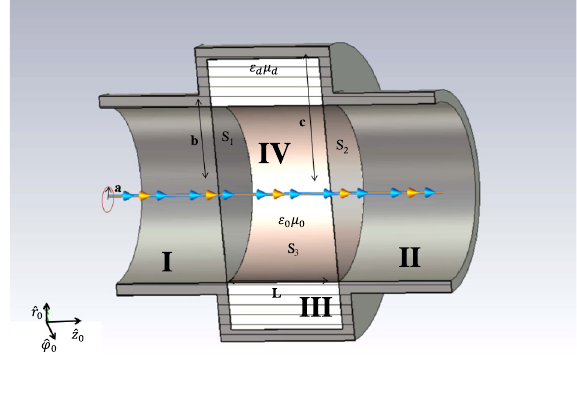
FIG. 1 (color online). Model studied with the mode matching method.